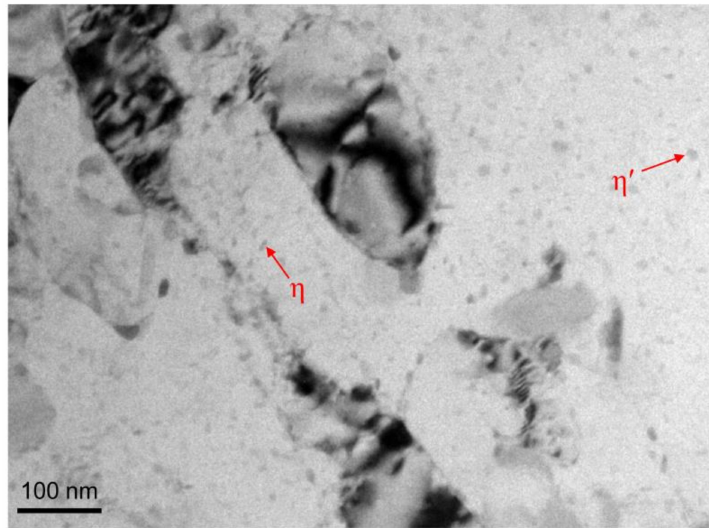
Figure 9. TEM microscopes Al 7075 subjected to RT-LSEM at a machining velocity of Vc = 21.6 m /